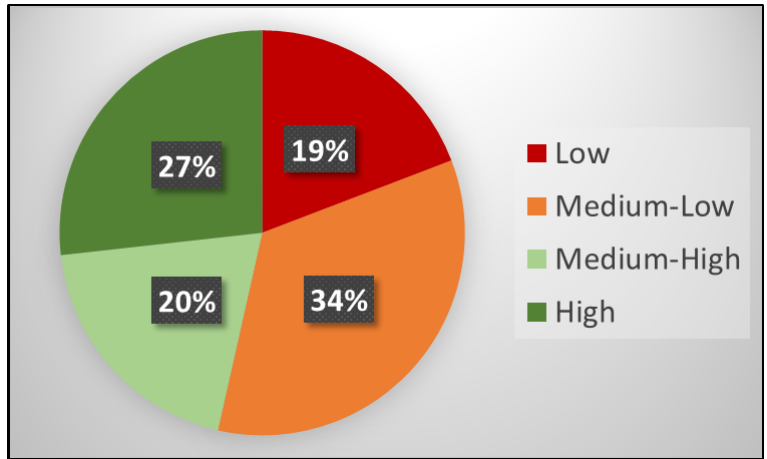
Figure 11. Hotel Guests’ Energy -Use Behavior Ability Level.